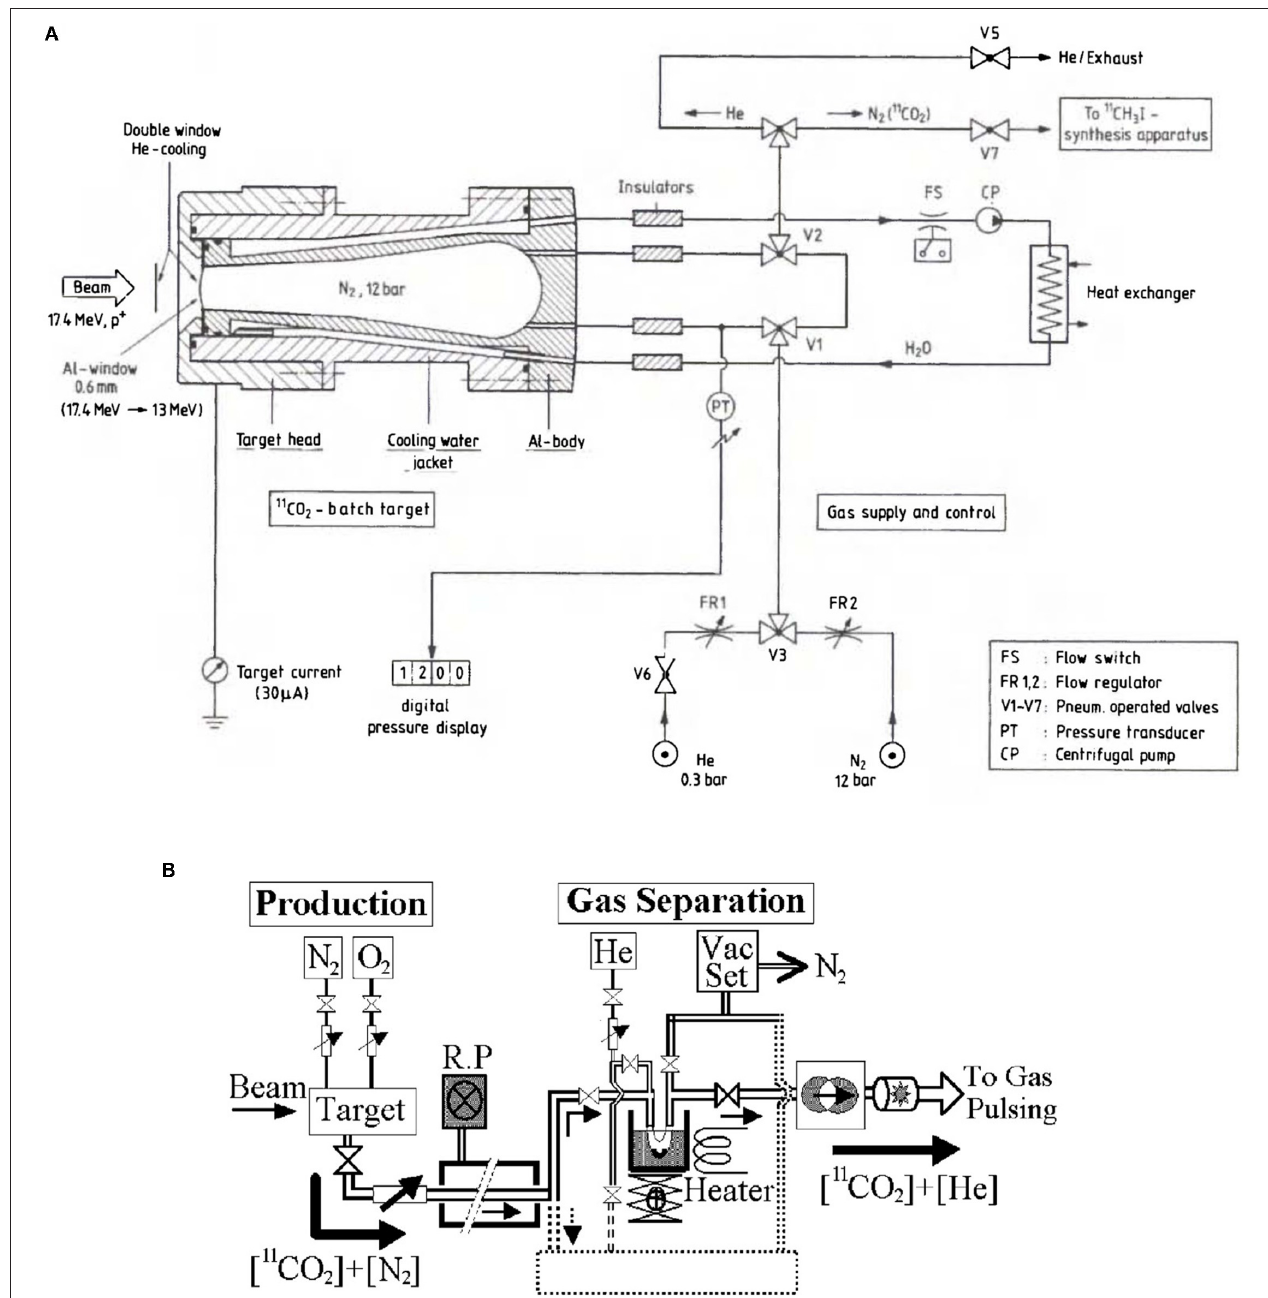
FIGURE 3 | Examples for a typical N 2 gas target system (A) and for a chromatography gas separation system (B) using a cryogenic trap (85,